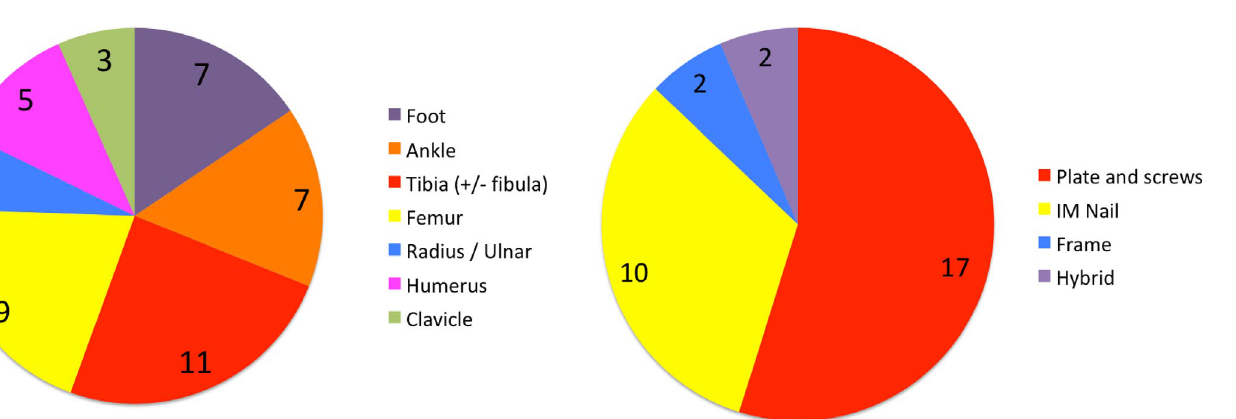
Figure 3. Pie chart demonstrating method of initial surgical stabilization used in an attempt to achieve bone union.